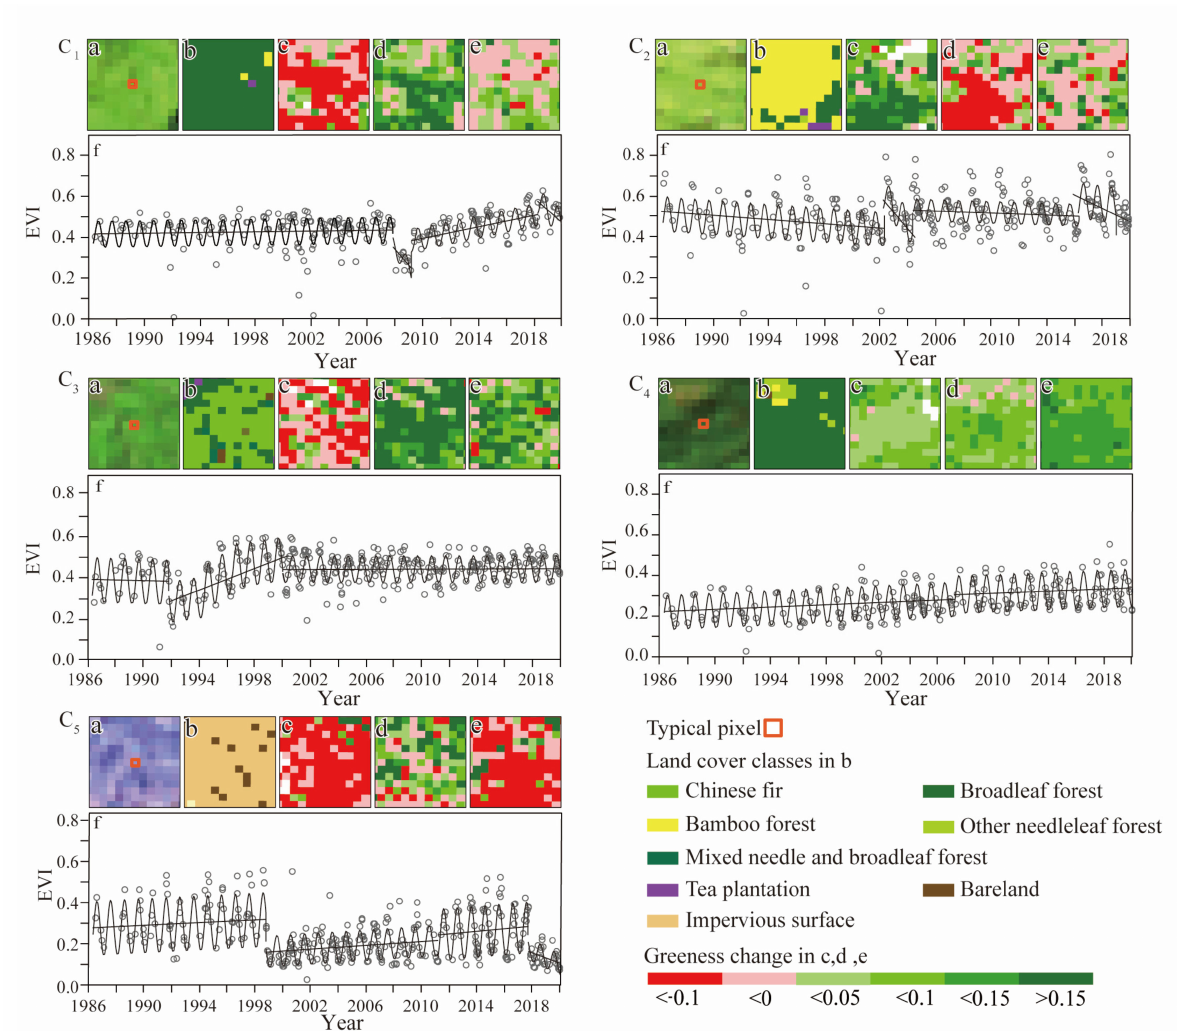
Figure 2. Vegetation change characteristics and detected breakpoints in typical land-cover types. C 1 and C 2 are broadleaf forest and bamboo forest, respectively, in Wuyishan Nature Reserve; C 3 is Chinese fir forest in Wuyishan National Park; C 4 and C 5 are broadleaf forest and construction land, respectively, in non-protected (NP) area. ( a ) Landsat OLI in 2020; ( b ) land-cover types in 2020; ( c ) cumulative abrupt change (A EVI ); ( d ) cumulative gradual change (G EVI ); ( e ) cumulative total change (T EVI ); ( f ) time-series fitting curve of typical pixels (black dots are observations and lines are fitted by harmonic